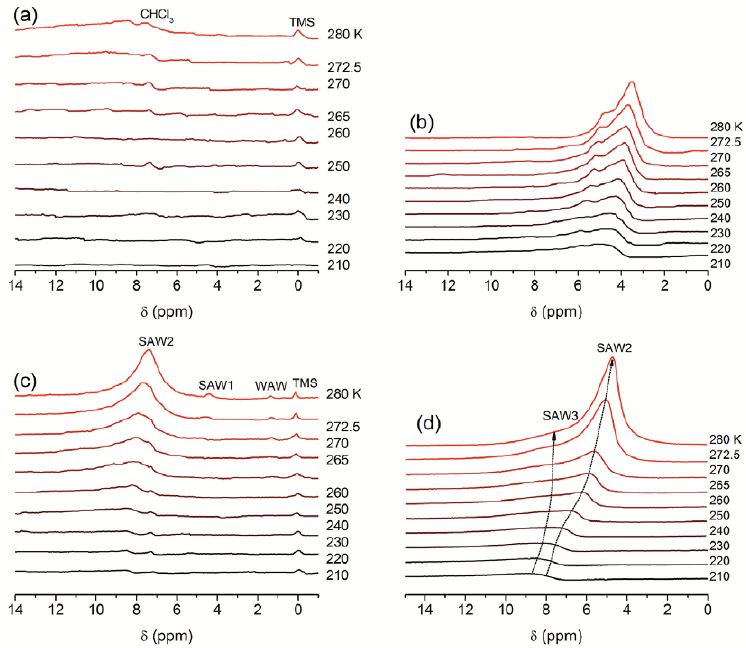
Figure 3. 1 H NMR spectra of water bound to NC (CDCl medium) at different hydration h = (a, b) 10 mg g -1 , (c) 60 mg g -1 and (d) 1 g g -1 ; (b) after 3 addition of NaOH to neutralize residual